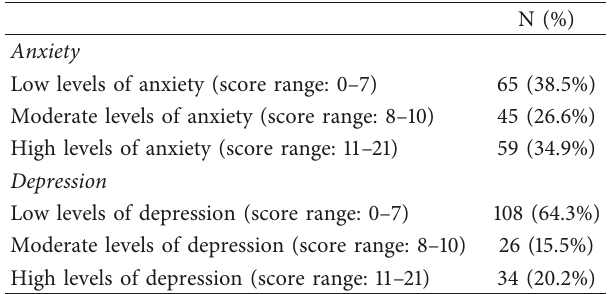
Table 1: Patients’ characteristics ( N � 170). Table 2: Levels of anxiety/depression of patients ( N �